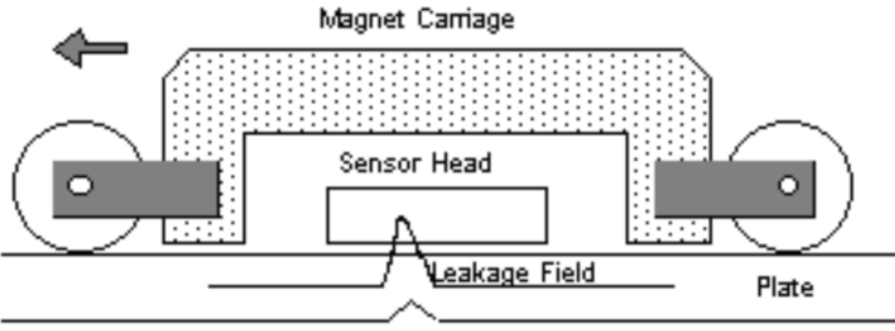
Figure 6. Example magnetic flux leakage device. (Reprinted from ref. [33]).